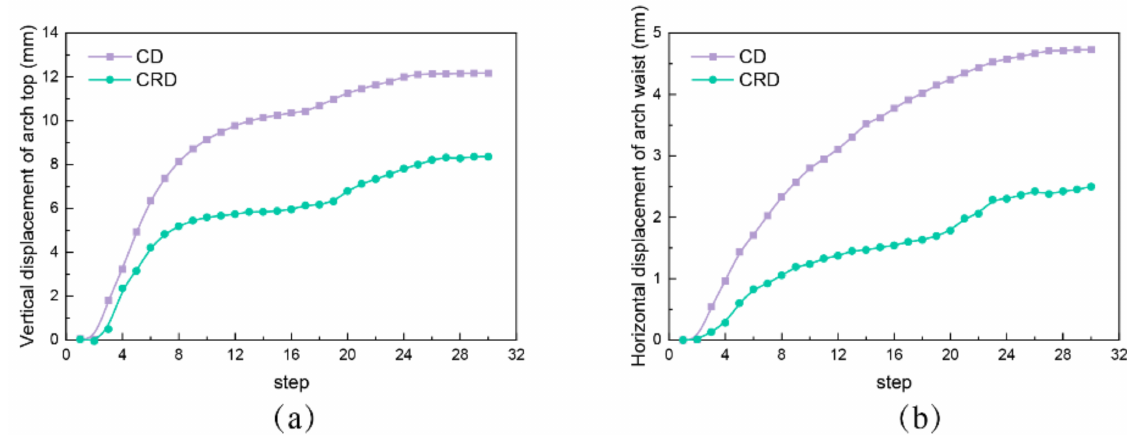
Figure 20. Comparison of tunnel settlement caused by CRD method and CD method during exca- vation: ( a ) comparison of vertical settlement of archtop; ( b ) comparison of horizontal convergence of arch waist.